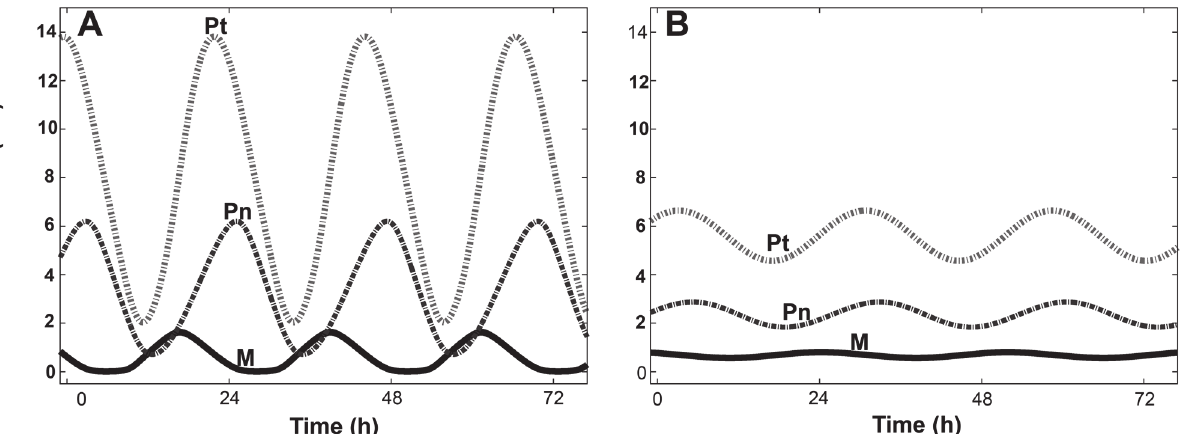
Figure 2. Sustained oscillations generated by the PER model. Temporal evolution of the variables M , P n , and P t , which represent the Per mRNA, nuclear PER and total PER, respectively. Repression of per transcription was assumed as a cooperative ( A ) or a non-cooperative ( B ) process. Parameter values are those listed in S1 Table in S1 File, except for the translation-related parameters, which, for this figure, acquired the following values: k s = 2 h − 1 , K r = 10 − 2 nM and V r = 10 − 2 nM h − 1